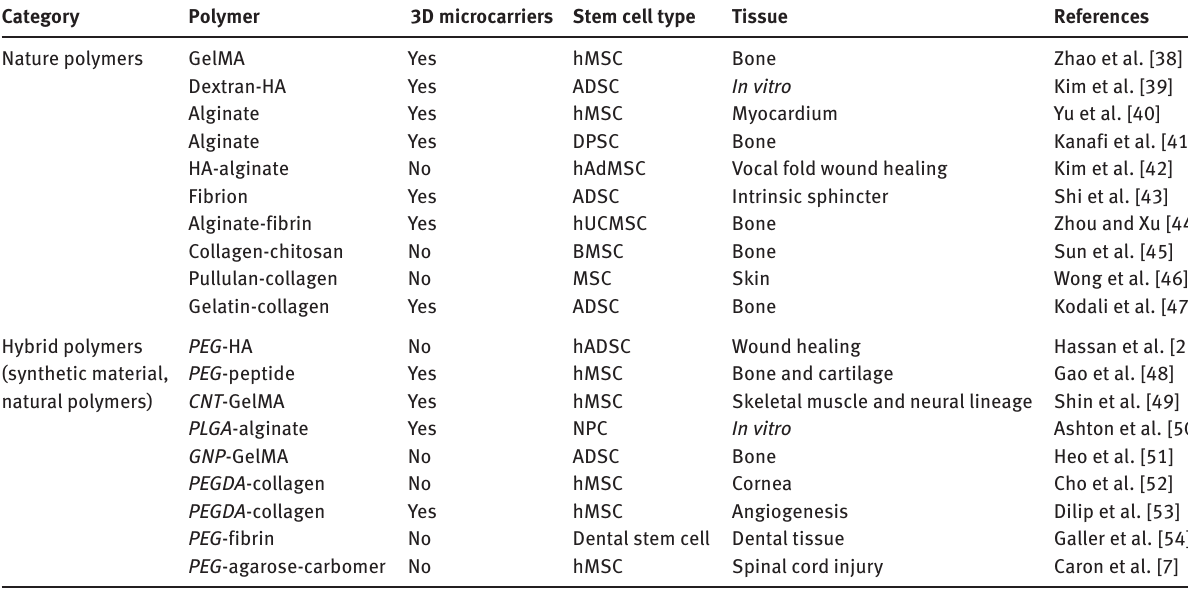
Table 2: The materials to fabricate hydrogel based 3D microcarriers.